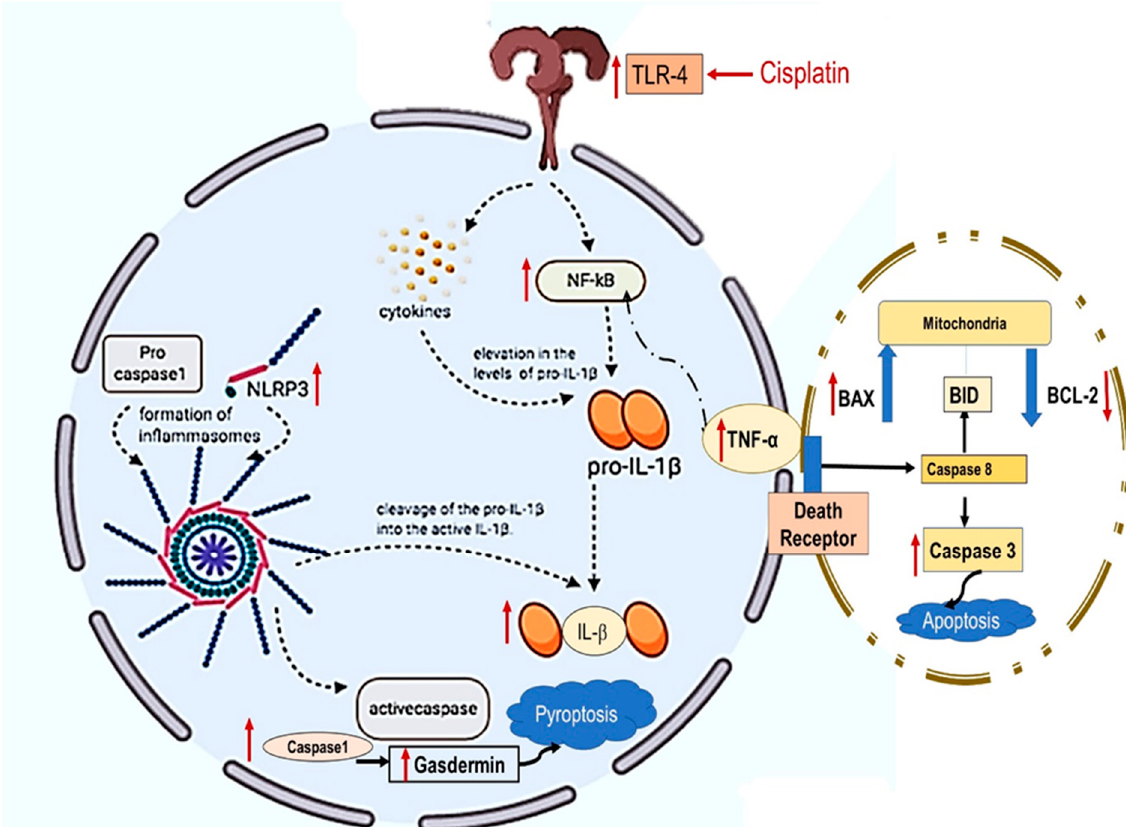
Figure 7. Cisplatin effect is represented as red arrows. TLR4: Toll-4 receptors; NF- κ B: Nuclear factor- α B; NLPR3: Inflammasomes; IL-1 β , and TNF- α ; Tumor necrosis factor- α .